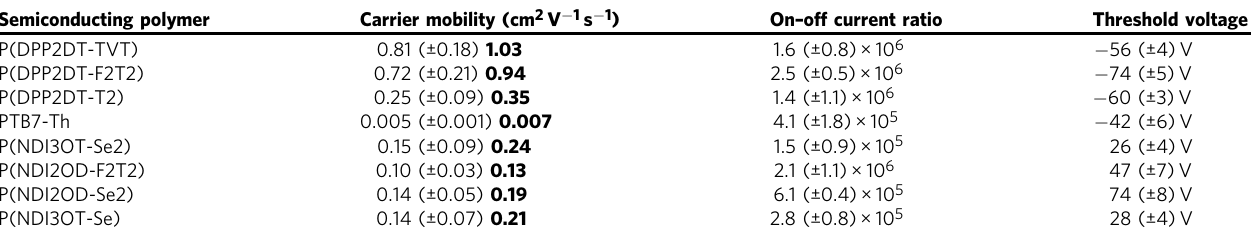
Bold numbers indicate the maximum mobility values obtained from each